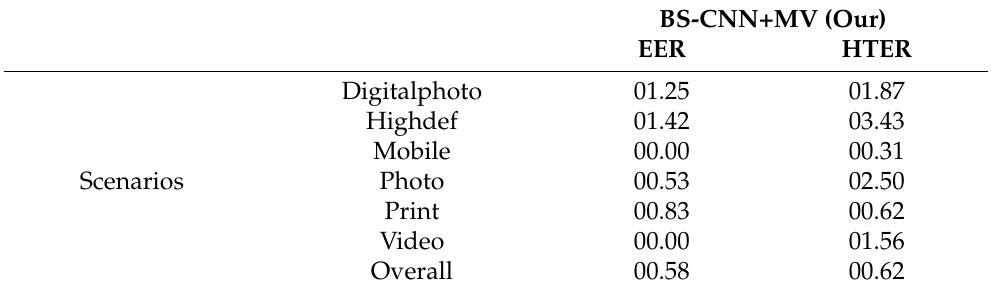
Table 4. Testing our proposed countermeasure using all scenarios of the REPLAY-ATTACK database.